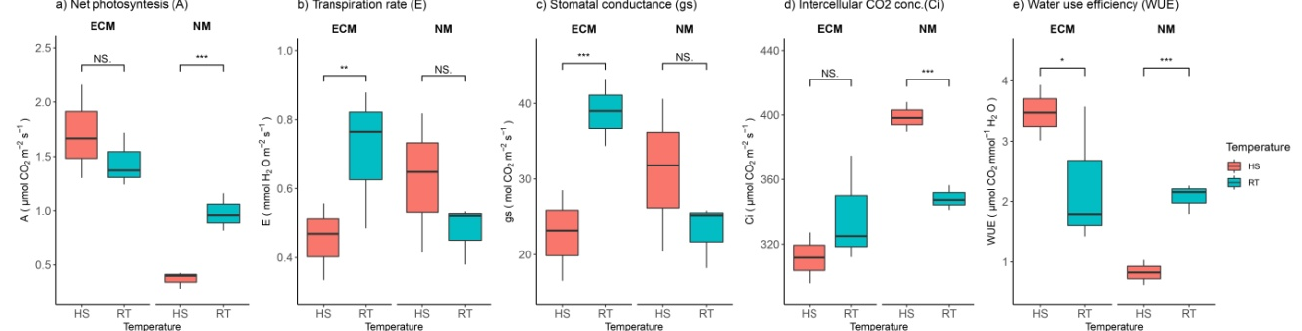
Figure 2. Changes in ( a ) net photosynthetic rate (A, mmol CO 2 m − 2 s − 1 ), ( b ) transpiration rate (E, mmol H 2 O m − 2 s − 1 ), ( c ) stomatal conductance (gs, mmol CO 2 m − 2 s − 1 ), ( d ) intracellular CO 2 con-